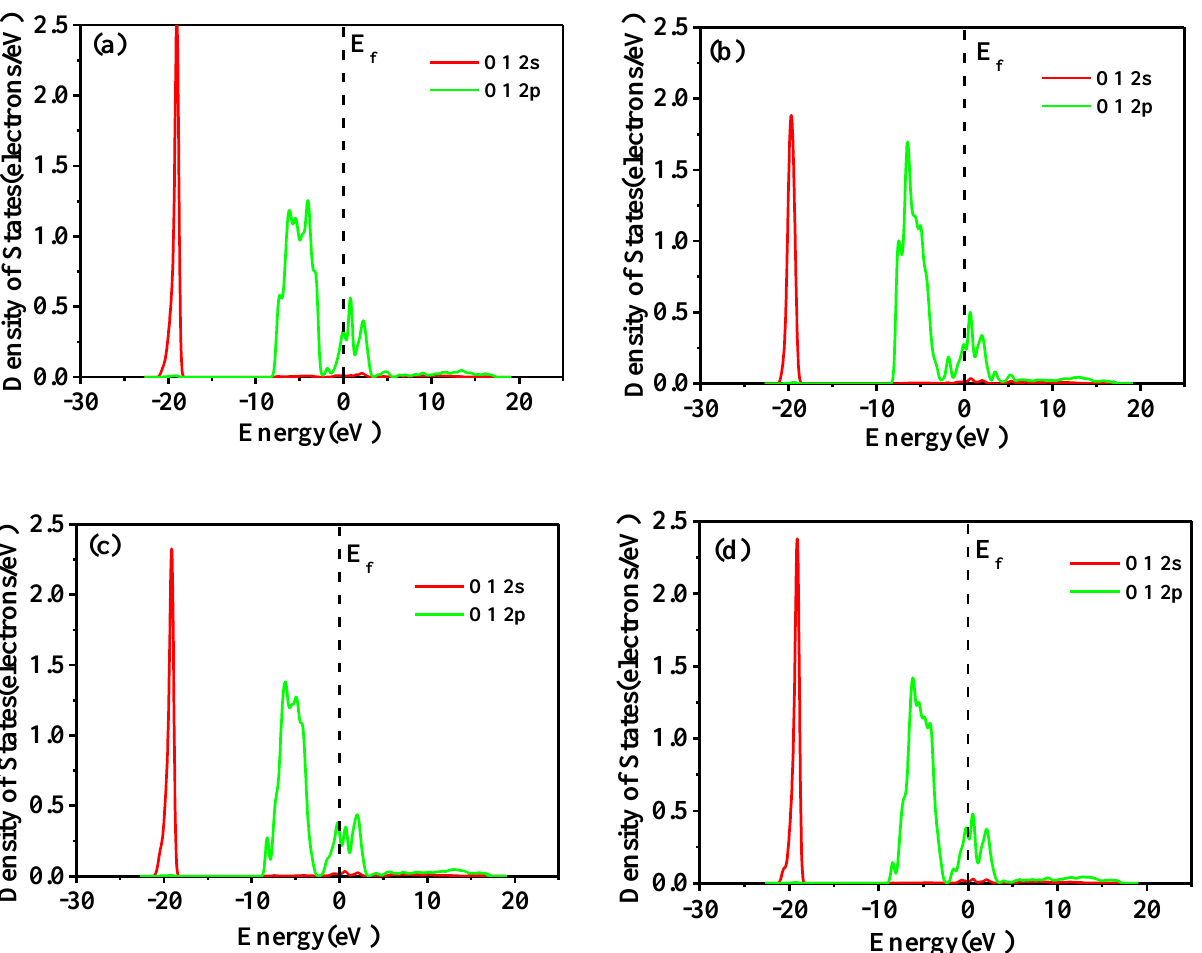
Figure 4. PDOS of O1 atom on the surface of different adsorption models. ( a ) Initial configuration, ( b ) after Cu 2+ adsorption, ( c ) after Cu(OH) + adsorption, and ( d ) After Cu(OH) 2 adsorption. Table 3. Interaction distance and adsorption energy of Cu species before and after adsorption on the surface of